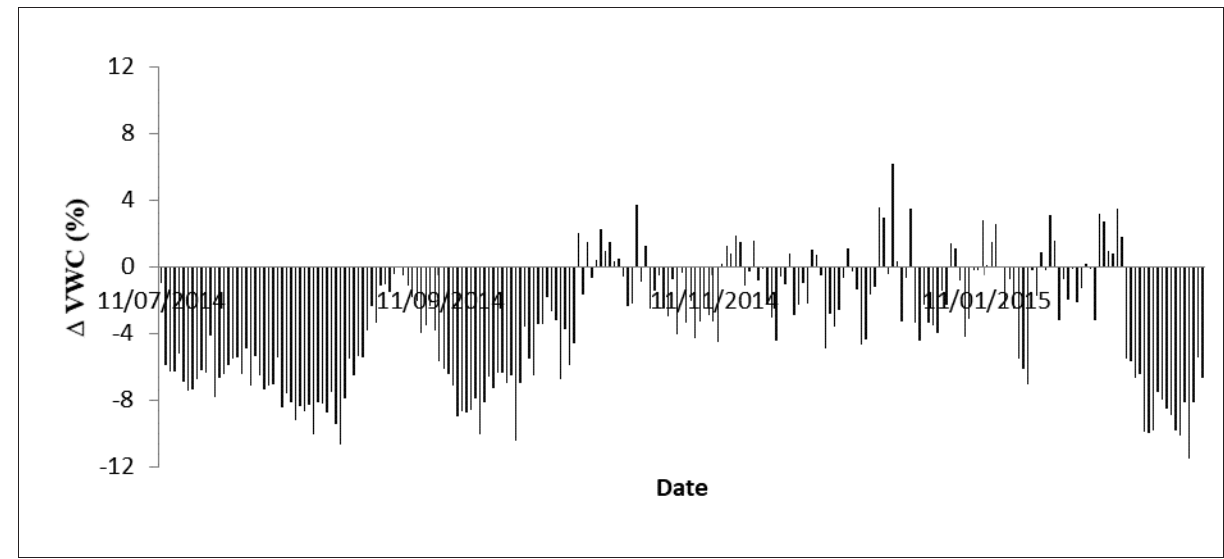
Figure 8: Residual graph of in-situ soil moisture estimates against those made using the cosmic ray